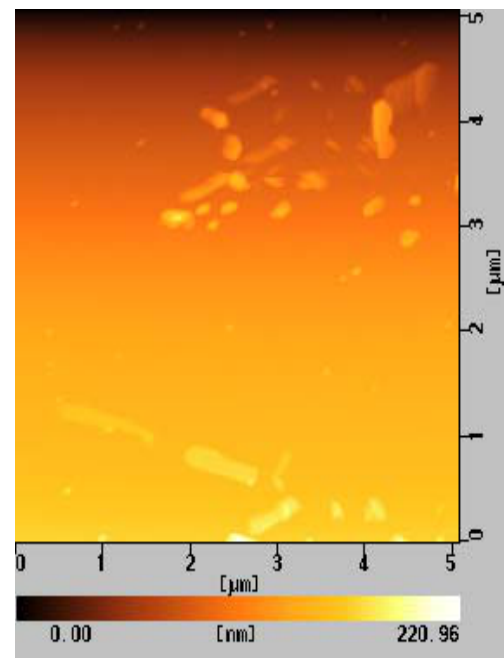
Figure 7. AFM observation of G0 (200 μ